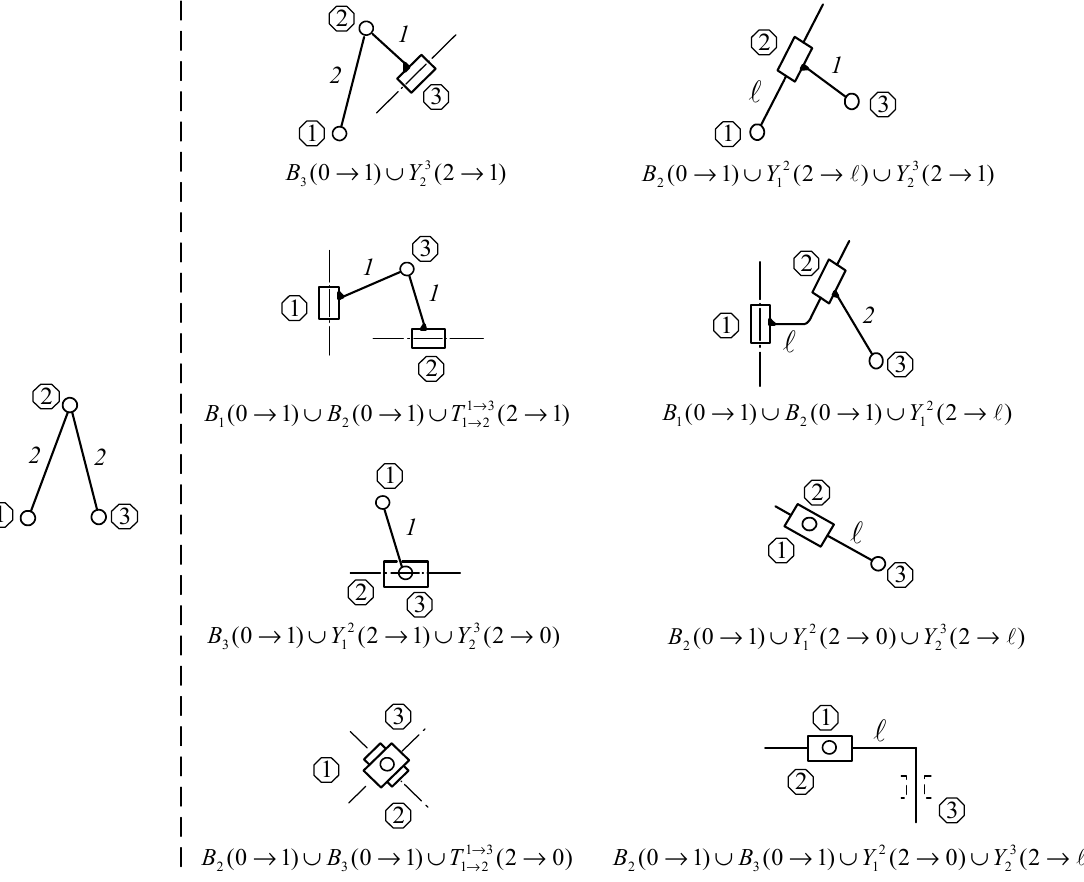
Figure 10. Configuration scheme set of Assur group II.